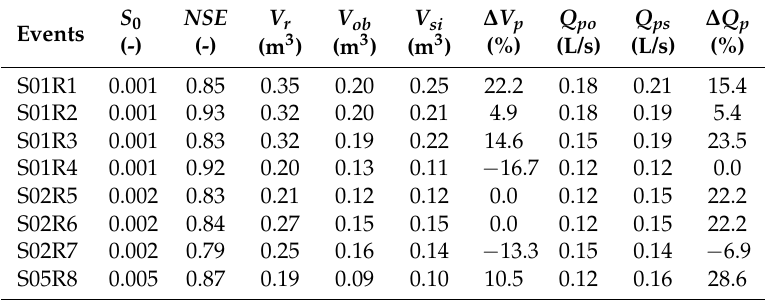
Table 2. Comparison of simulated and observed discharge and volume results for eight rainfall events.